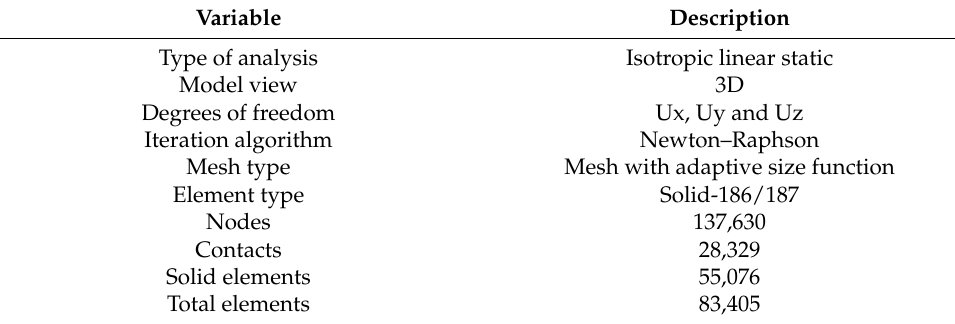
Figure 7. Maximum unit deformation, material aluminum 7075-O. Table 2 summarizes the finite element model applied in the simulation. Table 2. Conditions for finite element model in ANSYS ® Workbench ® .